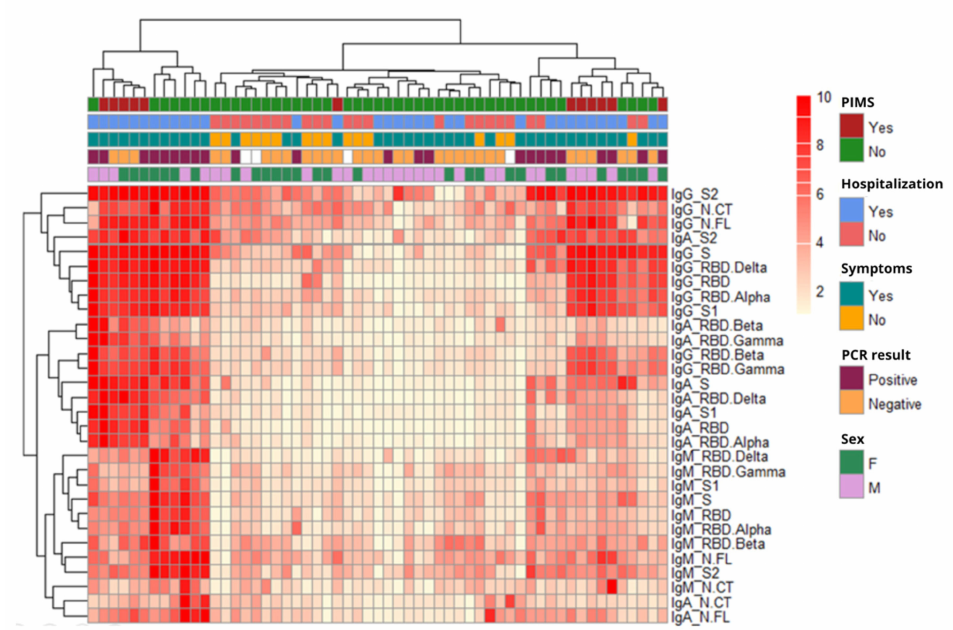
Figure 1. Heatmap with hierarchical clustering showing patterns of antibody responses (log 10 MFI) in children according to clinical and demographic data. White spaces represent missing